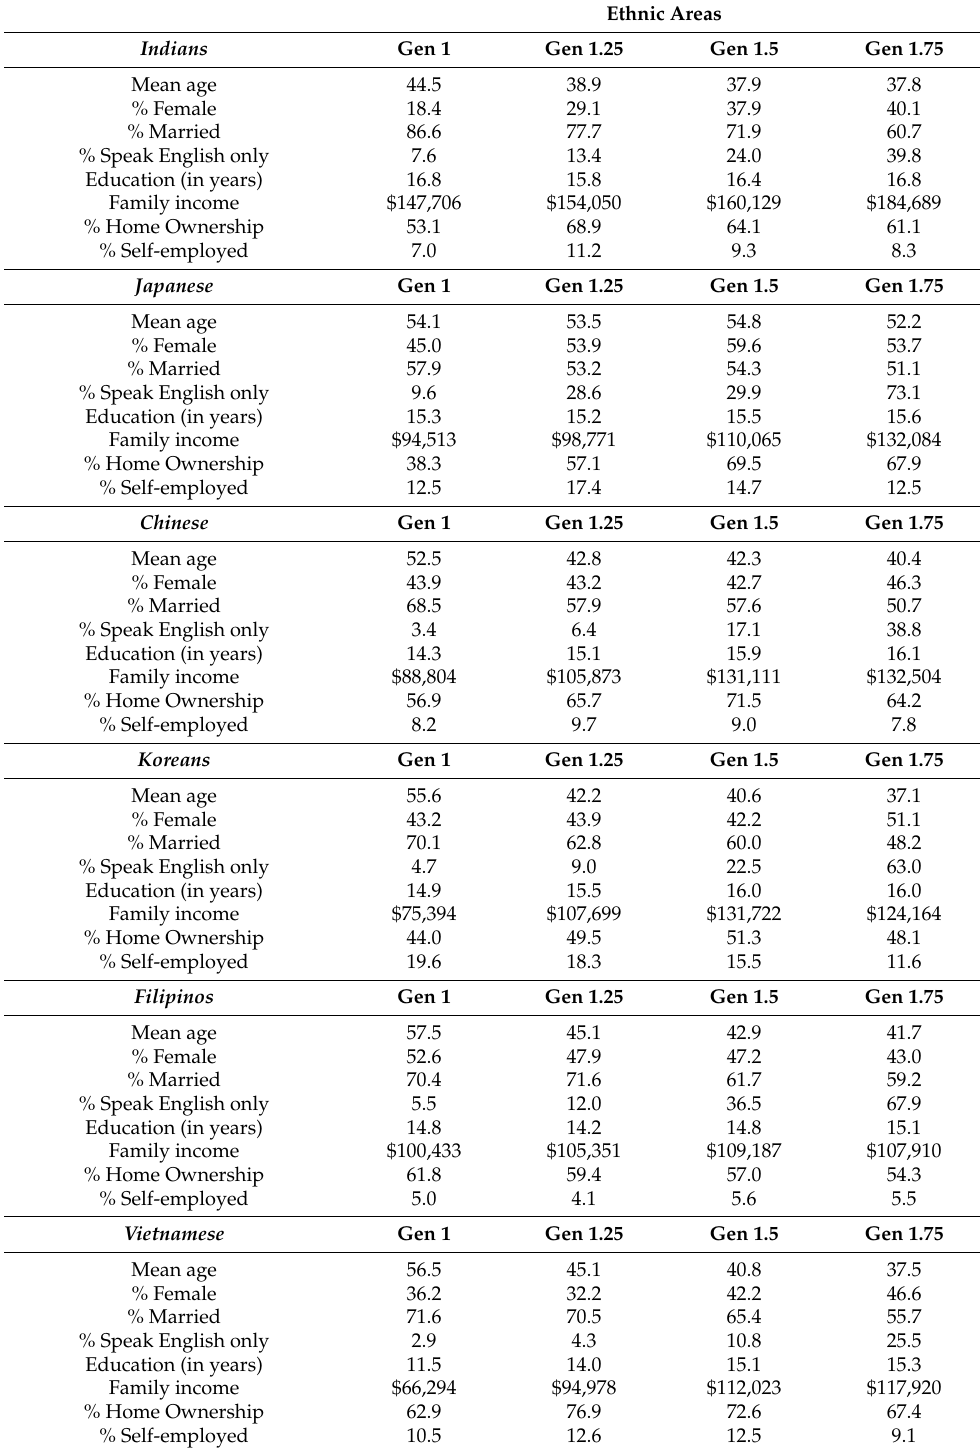
Table 2. Descriptive Statistics of Asian Immigrants by Ethnic Areas 2 and Generational Status,